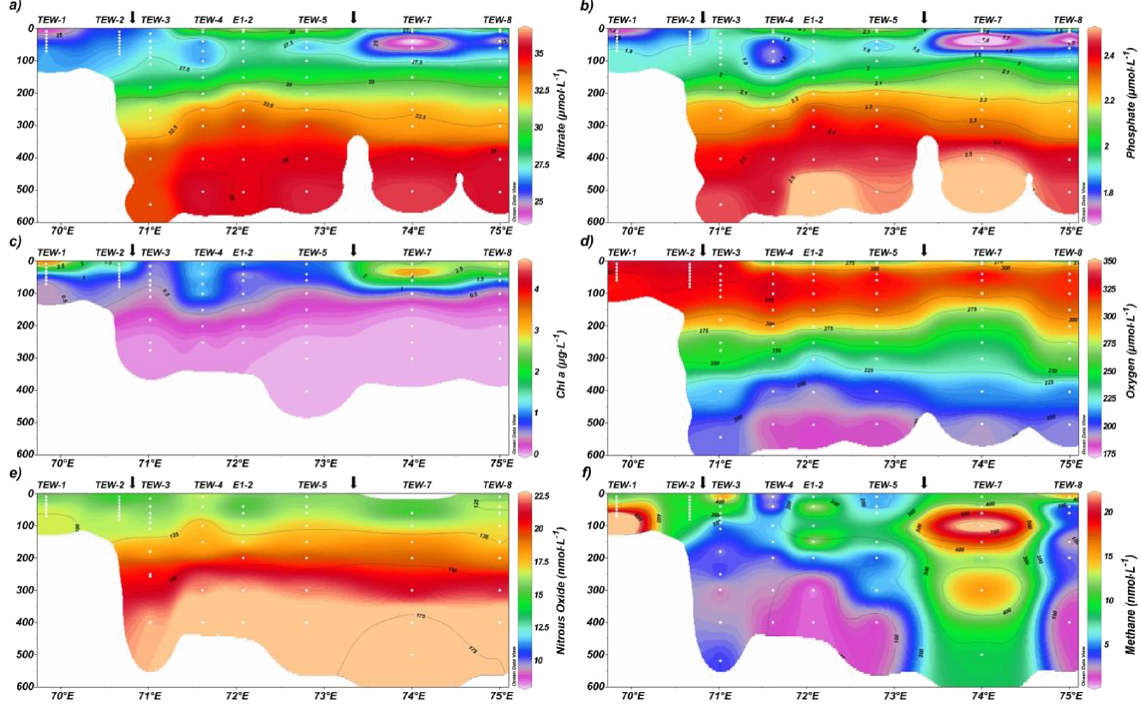
Figure 3. Vertical cross section of (a) nitrate (µmolL − 1 ) , (b) phosphate (µmolL − 1 ) ; (c) chlorophyll a (µgL − 1 ) , (d) dissolved oxygen (µmolL − 1 ) , (e) nitrous oxide (nmolL − 1 ) and (f) methane (nmolL − 1 ) for zonal transect between 69 and 75 ◦ E. Arrows indicate the position of the PF crossing this